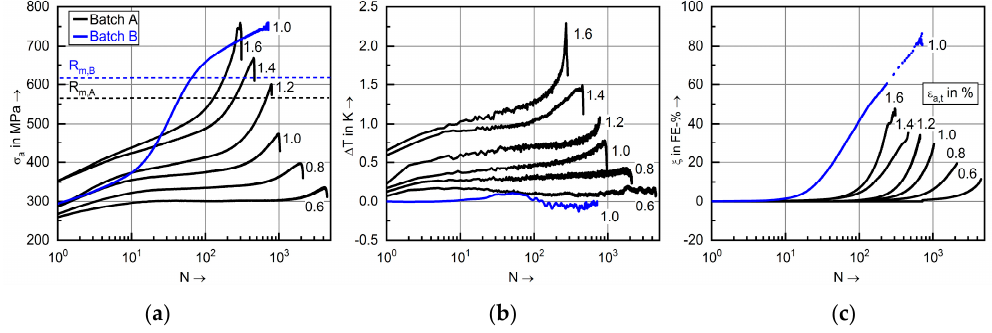
Figure 6. Development of ( a ) stress amplitude, ( b ) change in temperature and ( c ) α ’-martensite versus N during total-strain controlled LCF test of batch A and B.